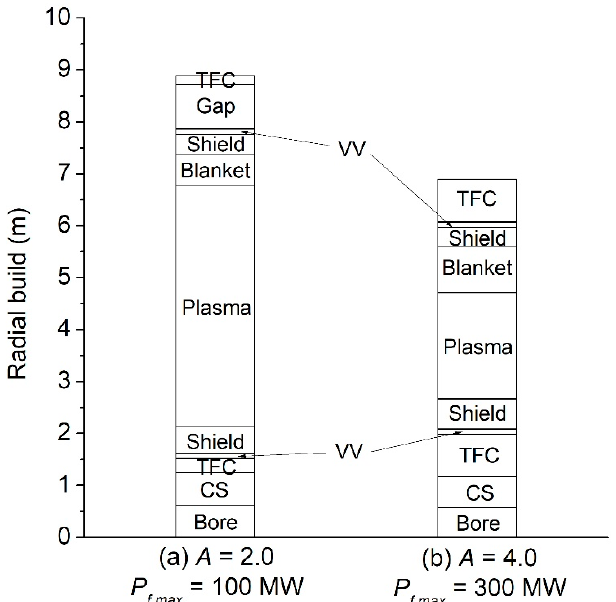
Figure 4. Optimal radial build of the transmutation reactor for ( a ) A = 2.0 with P f,max = 200 MW, and ( b ) A = 4.0 with P f,max = 300 MW, where TFC: toroidal field coil, CS: central solenoid, VV: vacuum vessel, and A : aspect ratio.